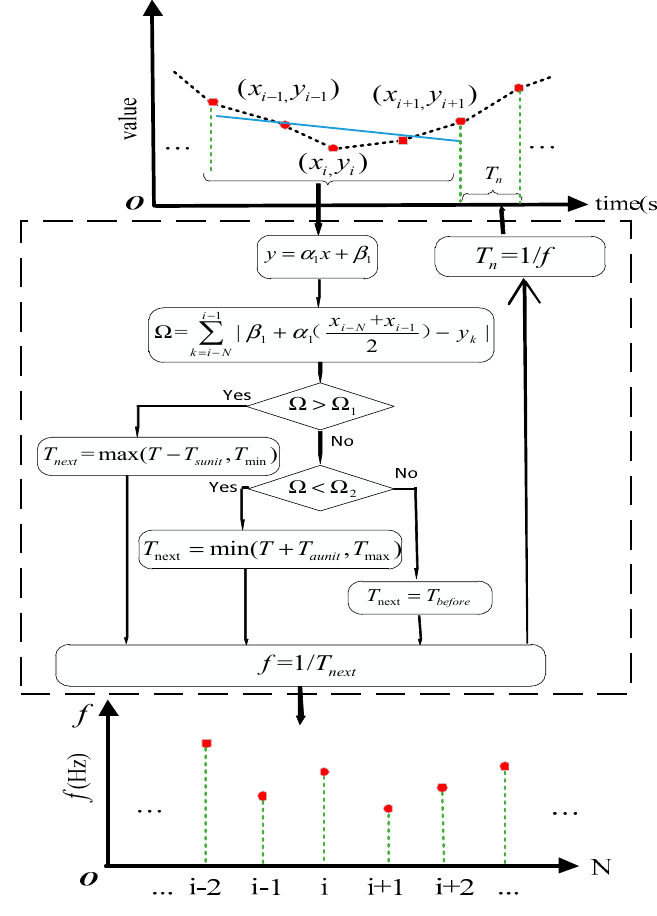
Figure 5. Adaptive sampling strategy.